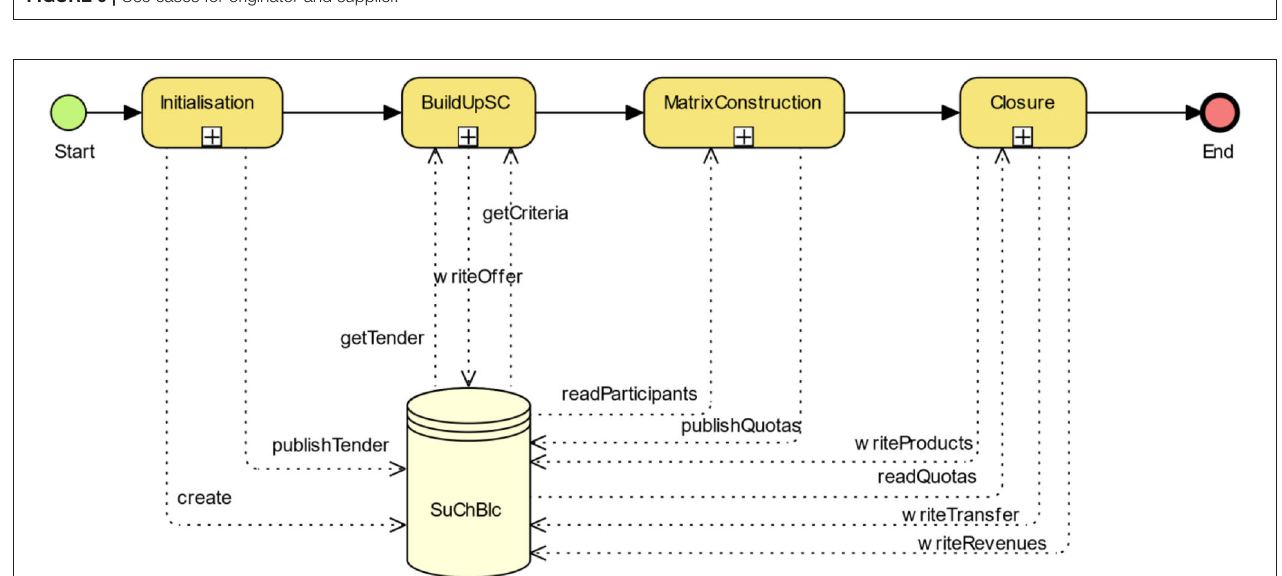
FIGURE 7 | A high-level view of the process associated with an intelligent smart